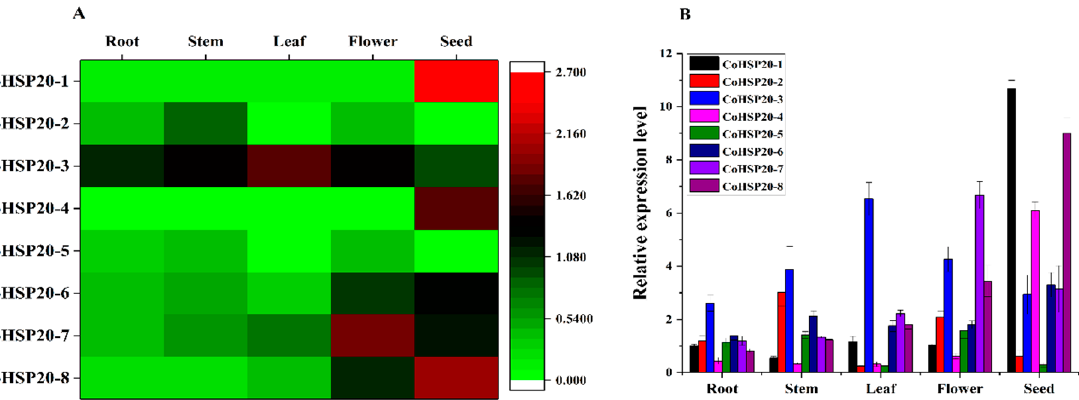
Figure 10. Heat map and following qRT ‐ PCR analysis of the Hsp20 genes in different organs. ( A ) Heat map depicting differential gene expression levels. ( B ) qRT ‐ PCR analysis.